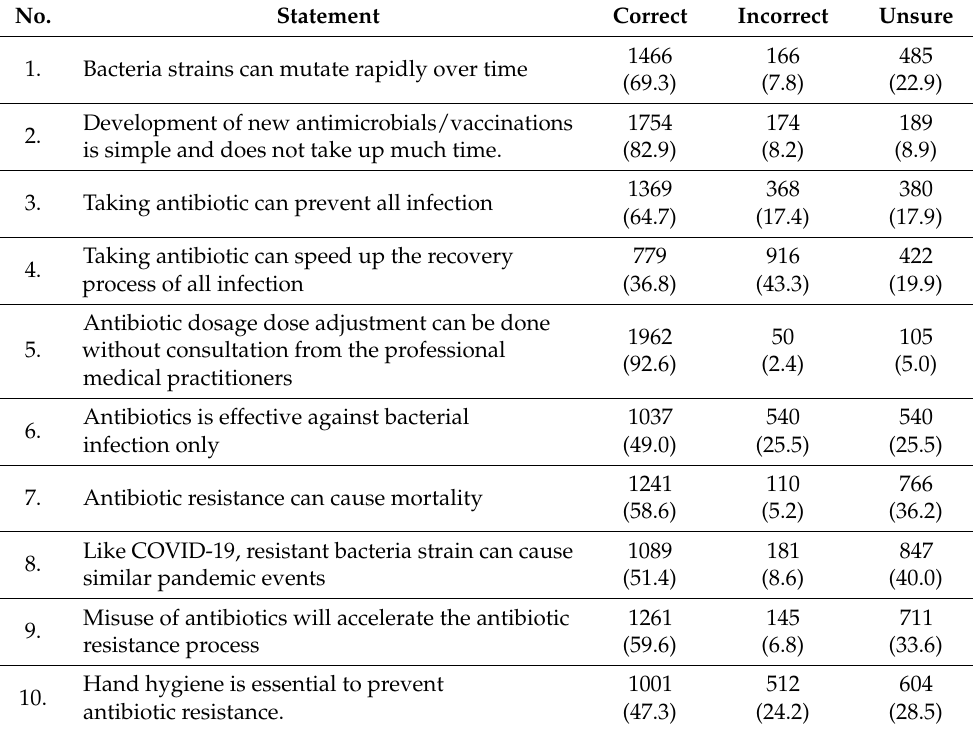
Table 5. Knowledge on antibiotics use and resistance ( n =